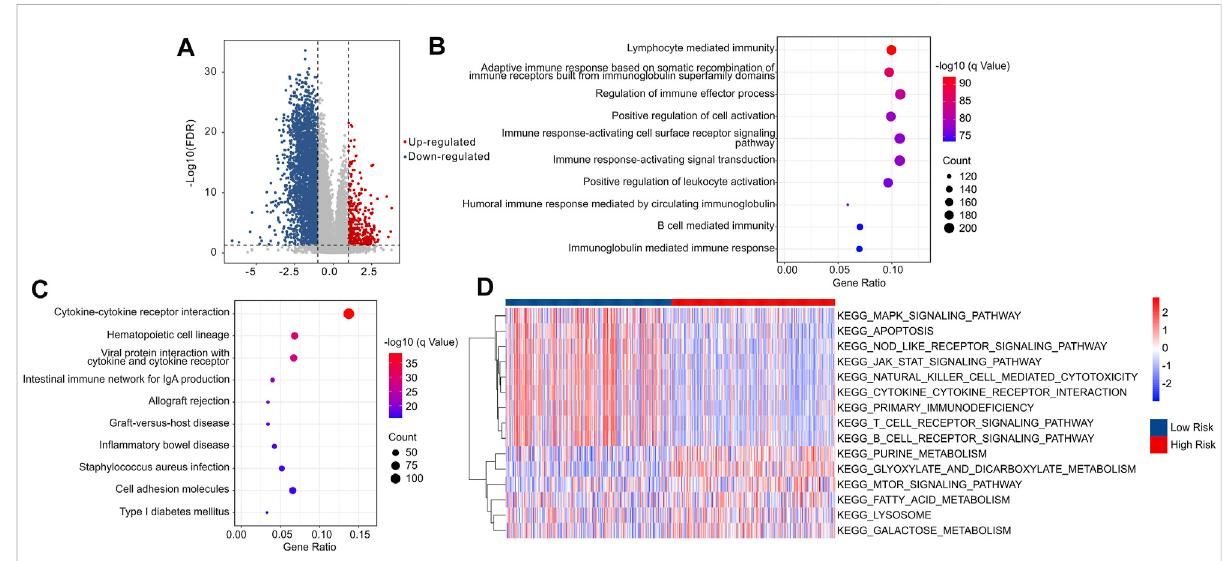
FIGURE 10 The functional enrichmentanalysisofDEGs between thelow- andhigh-riskgroups. (A) Thevolcano plotillustratedtheDEGs inlow- andhigh- risk groups with the threshold setting at |FC| ≥ 2 and FDR < 0.05. (B) GO enrichment analysis suggested that the DEGs were enriched in immune- related biological processes. (C) KEGG enrichment analysis indicated that the enrichment signaling pathways of DEGs. (D) GSVA revealed the KEGG terms of each CM patients in low- and high-risk